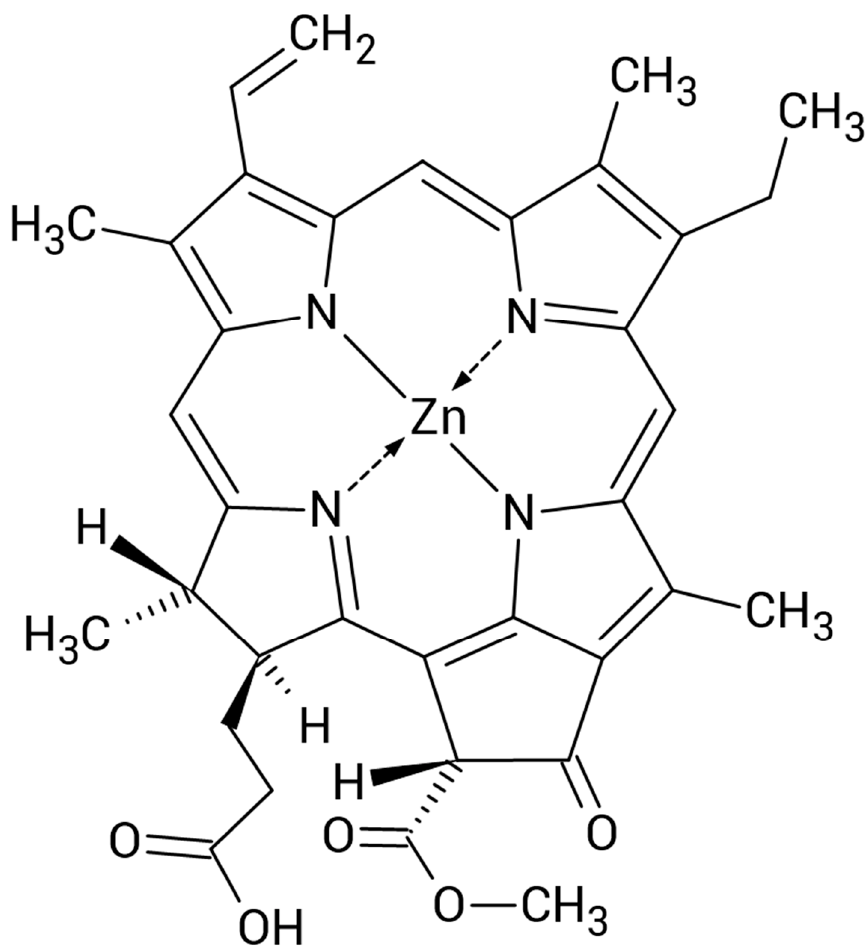
Figure 1. Chemical structure of zinc pheophorbide a.